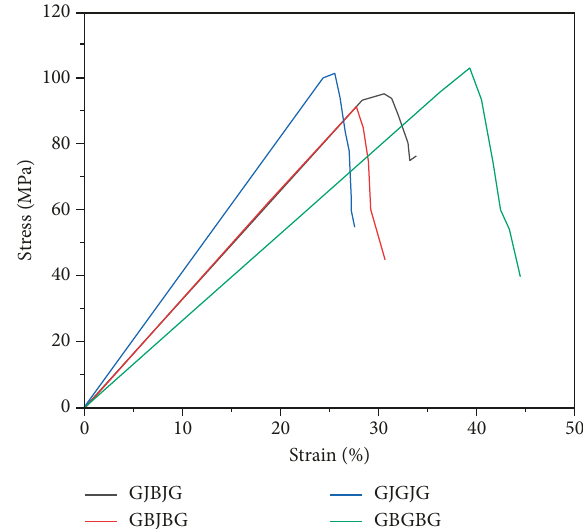
Figure 3: The composite stress-strain